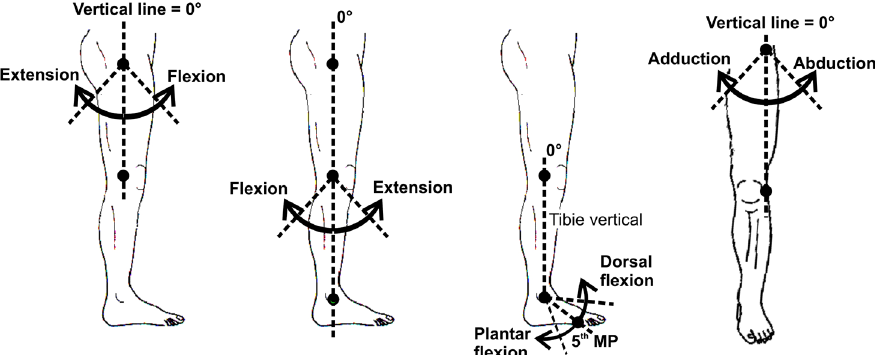
Fig.1 Relative angles of the measured joint